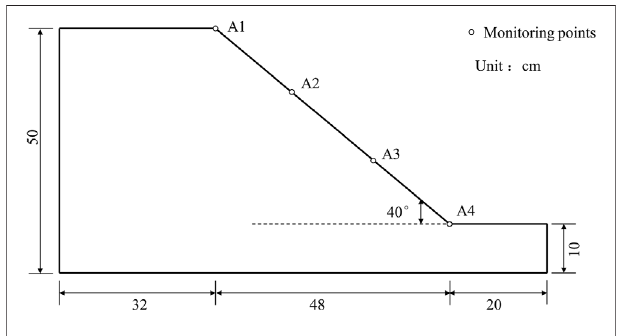
FIGURE 1 | Slope dimension and monitoring point locations.